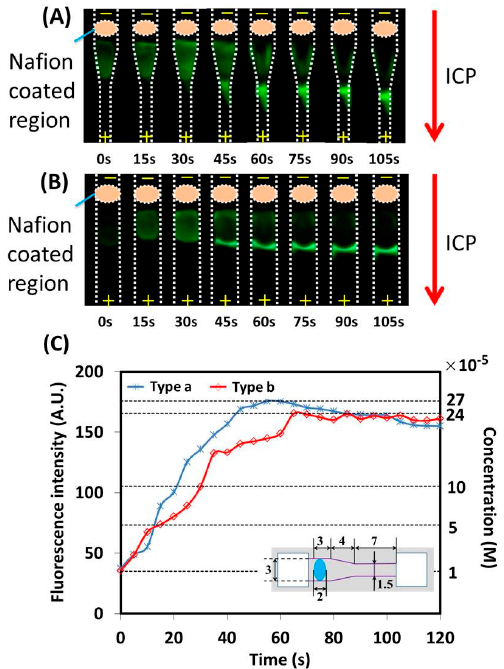
Figure 7. Experimental results with two types of ICP devices. ( A ) Fluorescence images captured at different times with ICP device type a; ( B ) Fluorescence images captured at different times with ICP device type b; ( C ) Variation of fluorescent signal intensity and corresponding sample concentration